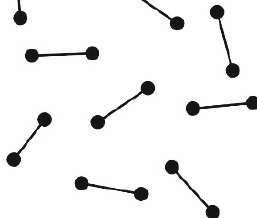
Figure 5. ( a ) Cloud of randomly oriented dipoles, ( b ) co-pol and ( c ) cross-pol polarimetric signatures characterizing scat- tering.